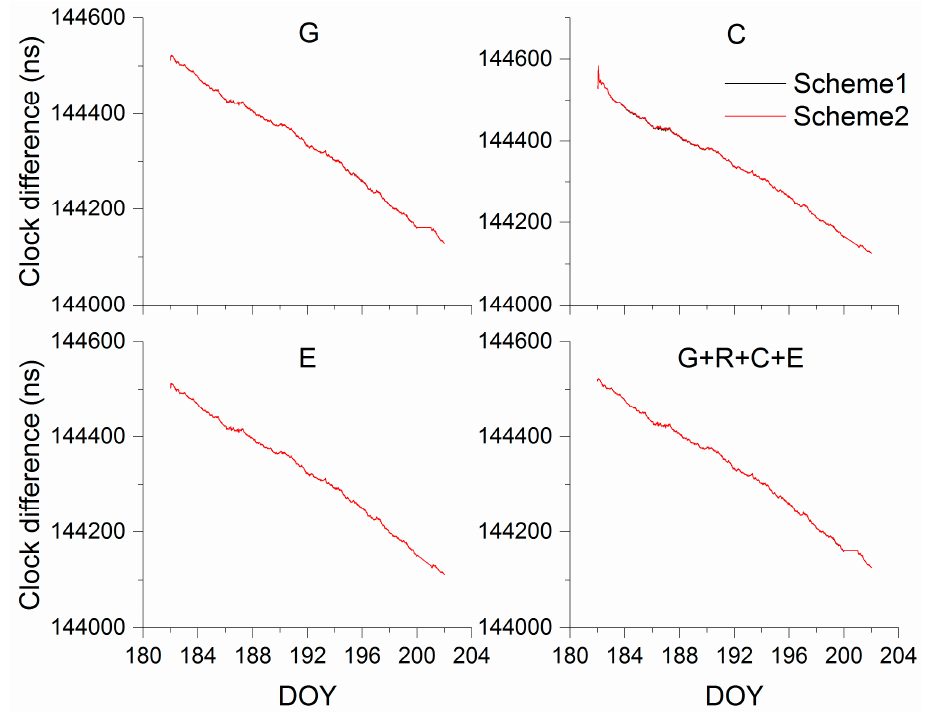
Figure 13. Clock differences of scheme1 and scheme2 with single-system and multi-GNSS models on HARB-NTSC using COD